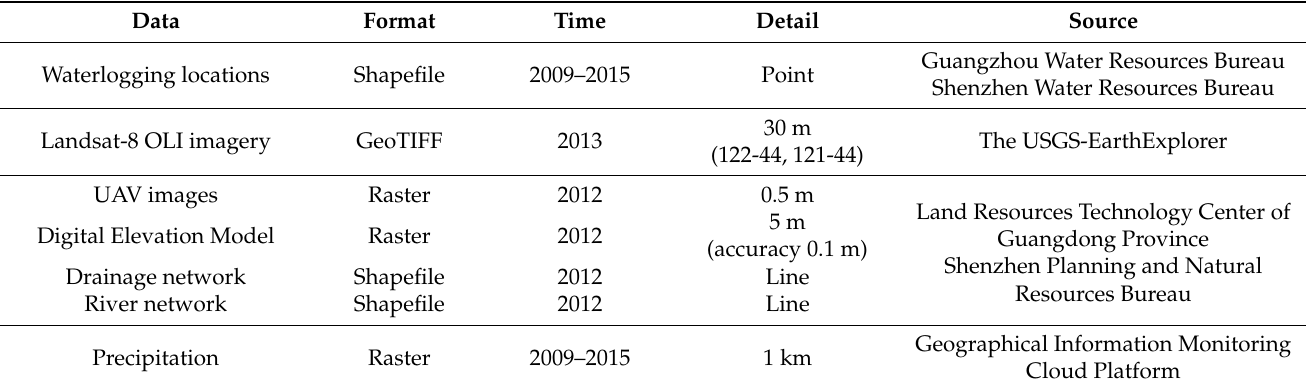
Table 1. List of the data